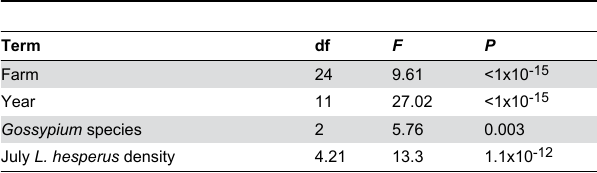
Table 2. Generalized additive model of factors associated with mid-season (July) retention of flower buds by cotton.